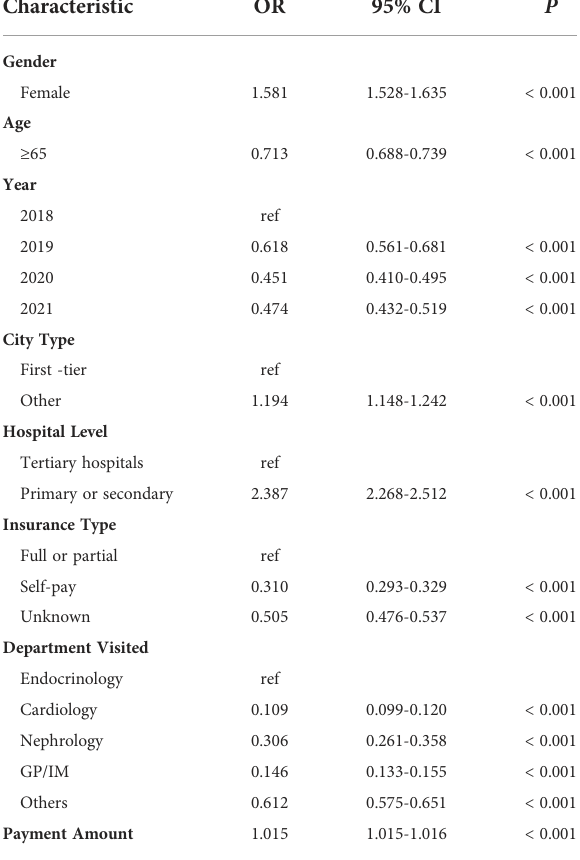
Table 2 The social-economic factors associated with selection of SGLT2i or GLP-1RA.